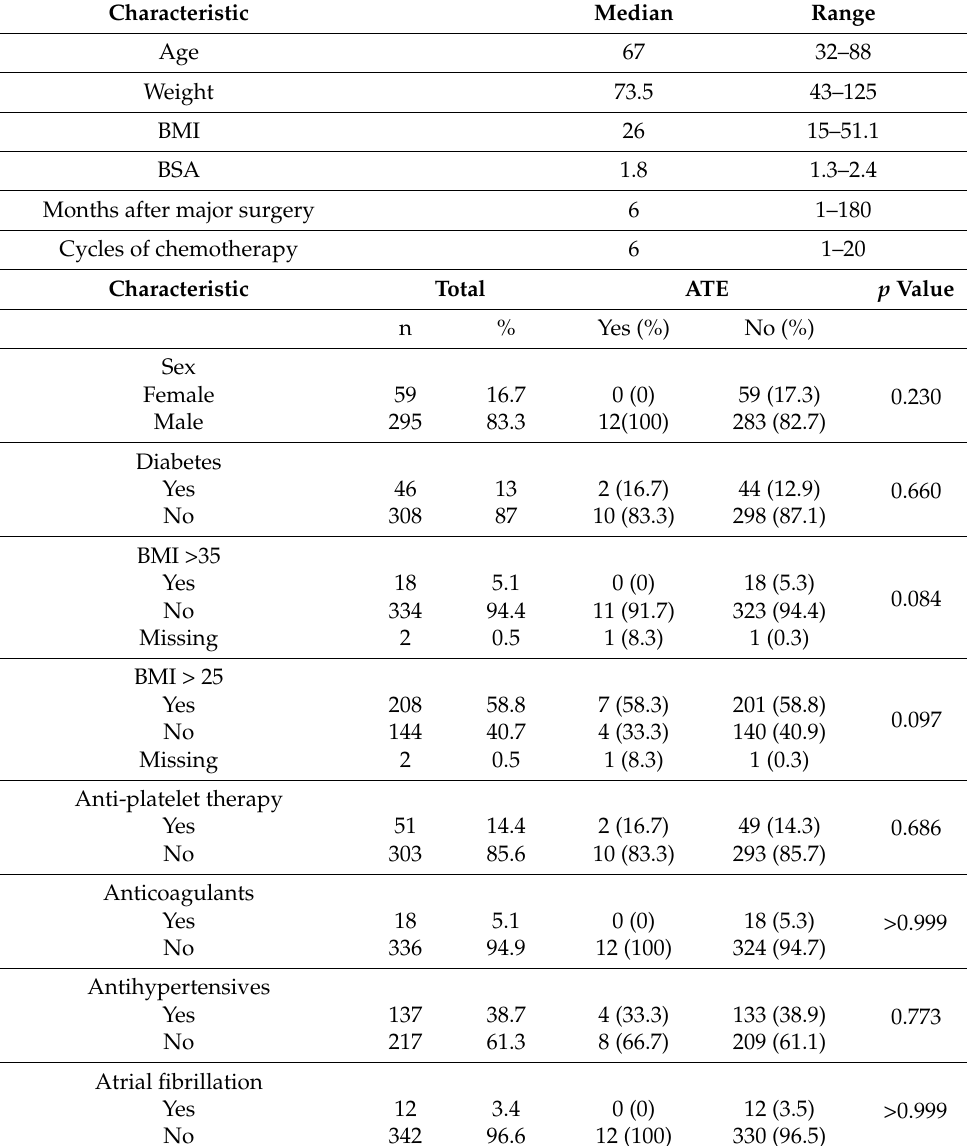
Table 1. Baseline characteristics of 354 patients with advanced urothelial cancer who were included in the